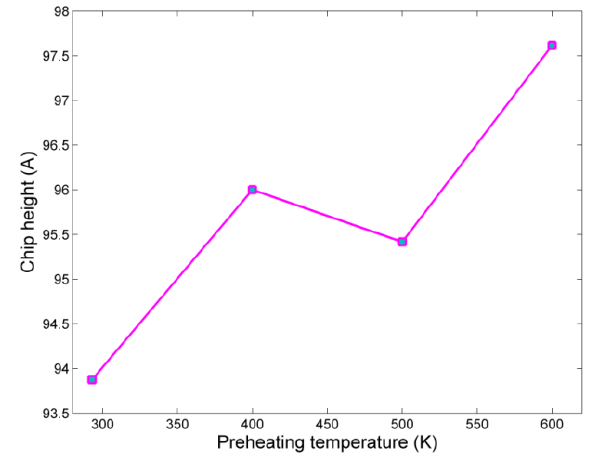
Figure 12. Chip height variation with respect to preheating temperature.